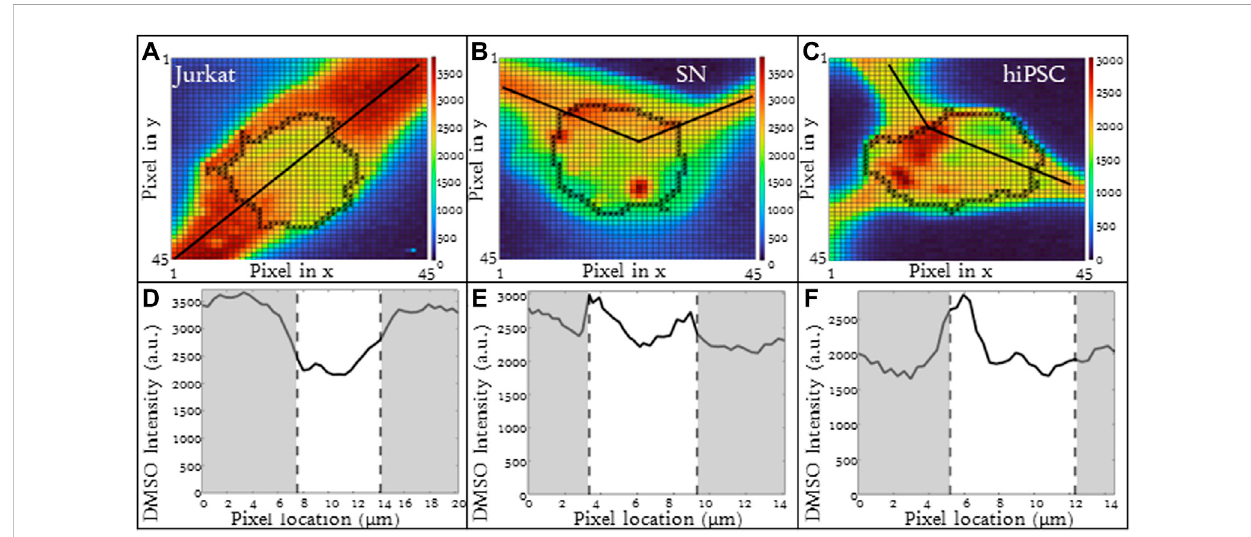
FIGURE 4 Raman heat maps of DMSO for a (A) Jurkat cell, (B) SN, and (C) hiPSCs in 10% DMSO frozen using a -1 ° C/min cooling rate and imaged at a temperatureof − 50 ° C.HeatmapsshowtheintensityofDMSO.LinescansacrosstheextracellularandintracellularspaceofeachshowDMSOvariationfor each cell type (D) Jurkat cell, (E) SN, and (F) hiPSCs. Gray areas indicate extracellular regions and white areas indicate intracellular regions. Pixels in (A – C) have a height and width of 333